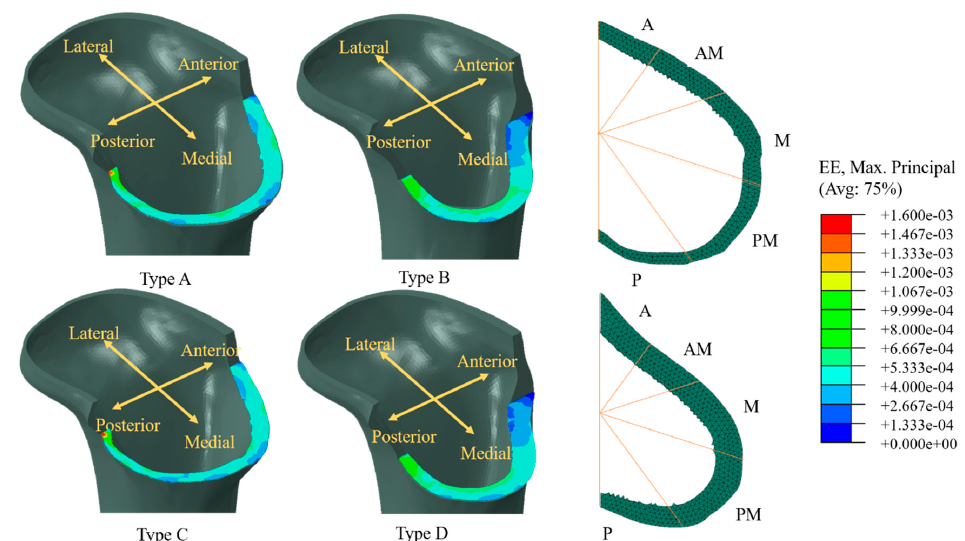
Figure 6. Representative strain distributions on the resected surface of the cortical bone of the proximal tibia for the metal block augmentations of the medium and large uncontained bone defects. Type A: Double metal block augmentation for medium uncontained bone defect, Type B: Double metal block augmentation for large uncontained bone defect, Type C: Single metal block augmentation for medium uncontained bone defect, Type D: Single metal block augmentation for large uncontained bone defect. (A, anterior; M, medial; L, lateral; P, posterior regions).